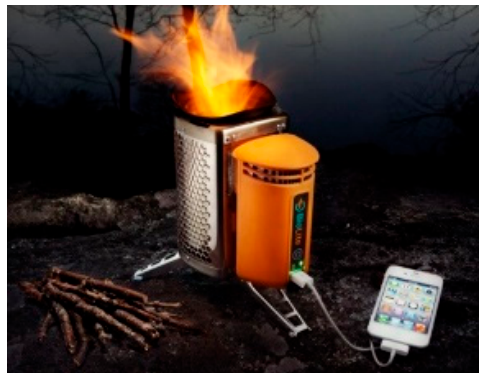
Figure 9. Picture of a CampStove [122].